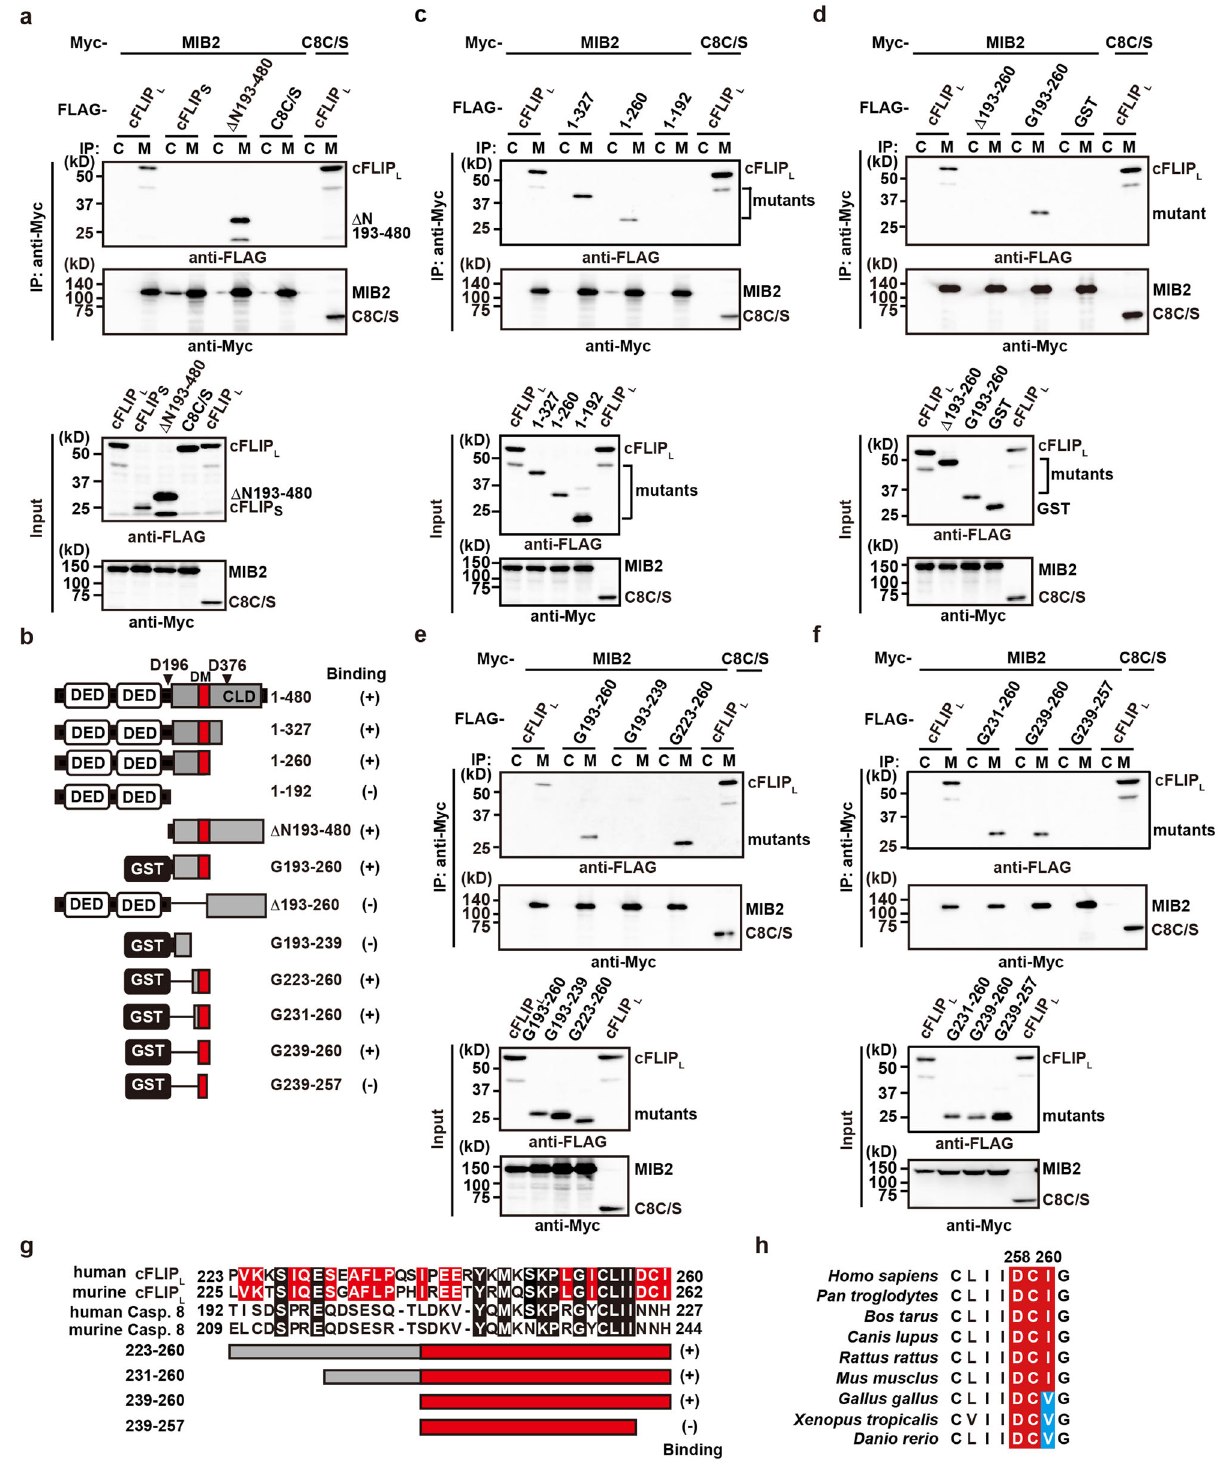
Fig. 2 Delineation of the cFLIP L domain responsible for interaction with MIB2. a , c – f HEK293 cells were transfected with the indicated expression vectors and analysed as in Fig. 1e. b Diagrams of cFLIP L deletion mutants and GST-fusion proteins containing the indicated amino acids of cFLIP L , and a summary of their binding to MIB2 using co-transfection experiments. C8C/S, a protease-inactive mutant of caspase 8; DED, death effector domain; CLD, caspase-like domain; GST, glutathione S-transferase. D196 and D376 indicate the location of aspartic acid residues cleaved by activated caspase 8. All results are representative of two independent experiments. g Amino acid alignment of human and murine cFLIP L and caspase 8. GST-cFLIP L mutants containing the corresponding amino acids and their MIB2 binding ability are shown. Red boxes indicate a docking site for MIB2 (DM). h Alignment of the DCI sequences of cFLIP L among various species. Red and blue boxes highlight identical and similar amino acids to the DCI sequence, respectively. Each number indicates the position of the amino acids of human cFLIP L